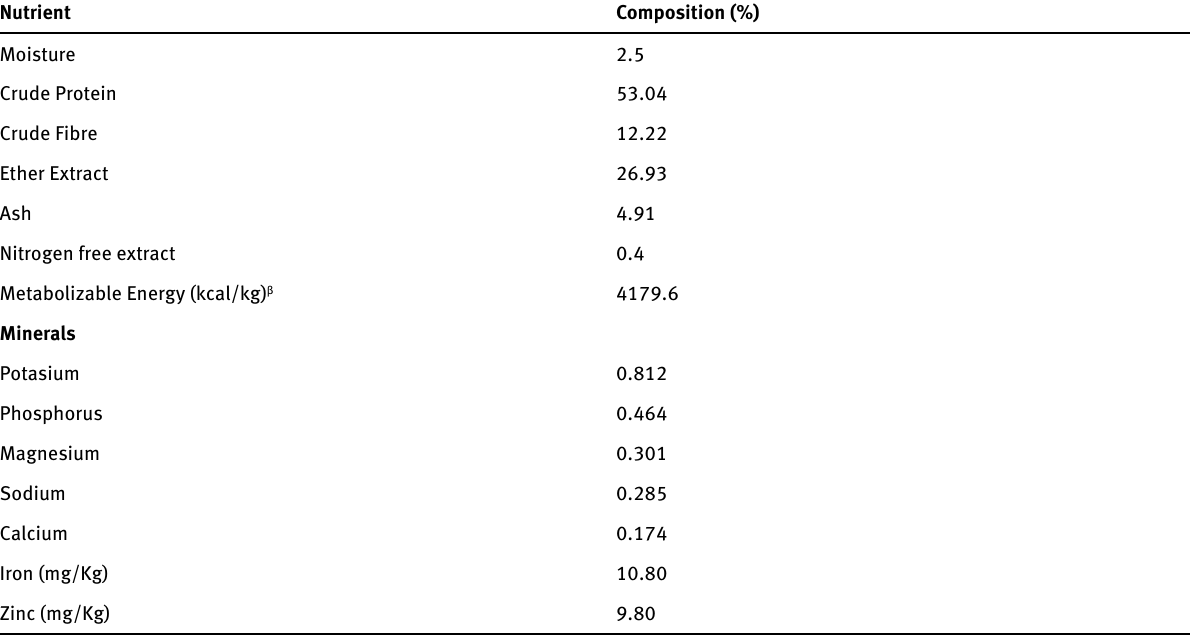
Table 2: Nutrient Composition of Cockroach Meal Nutrient Moisture